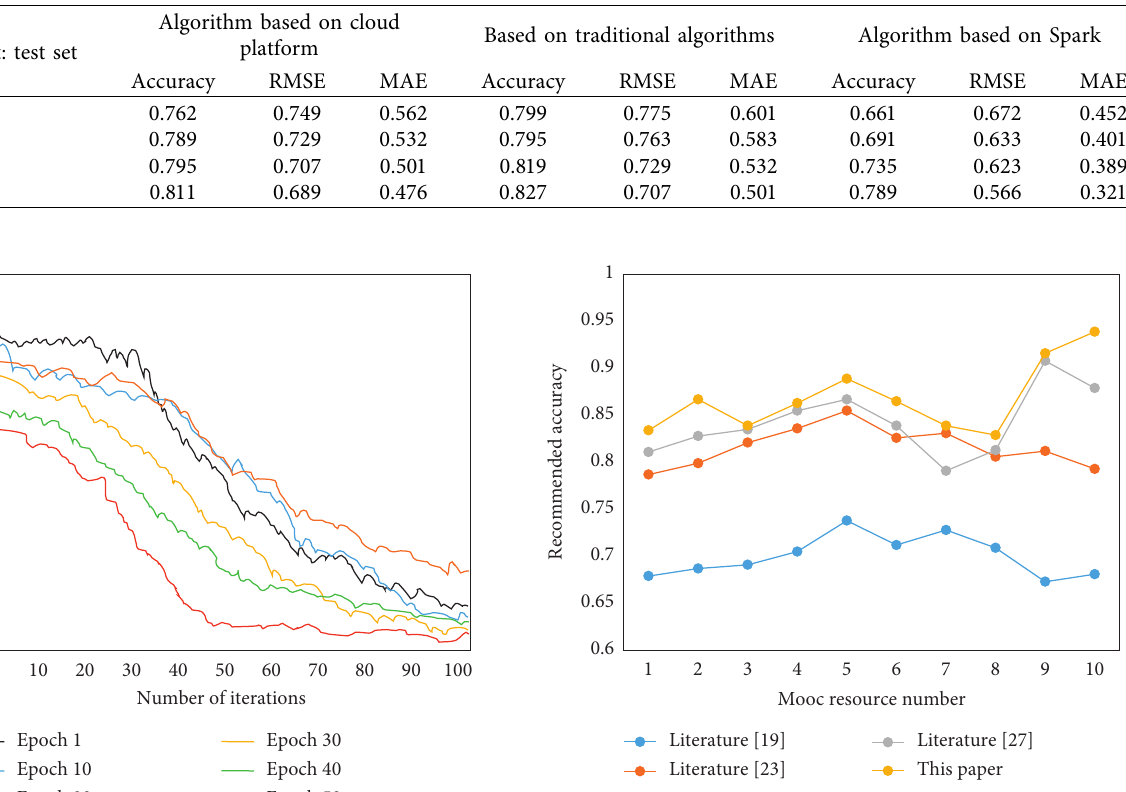
Figure 9: Comparison of recommendation accuracy of MOOC resources with different